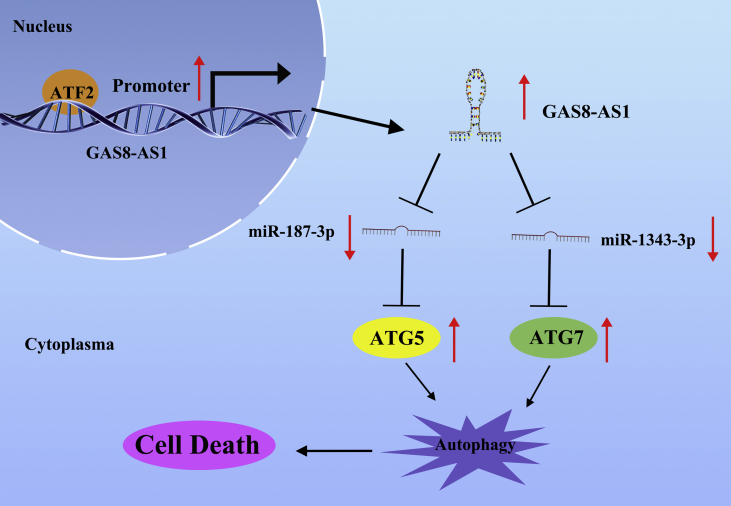
Summary of the Regulation and Mechanism of GAS8-AS1 in PTC Cells